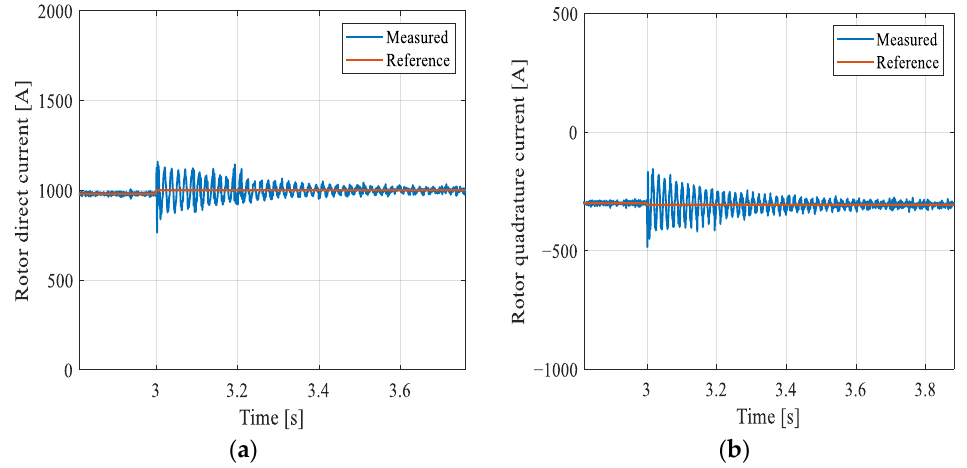
Figure 20. Rotor currents during an unbalanced voltage sag of 70%: ( a ) d axis component and ( b ) q axis component.